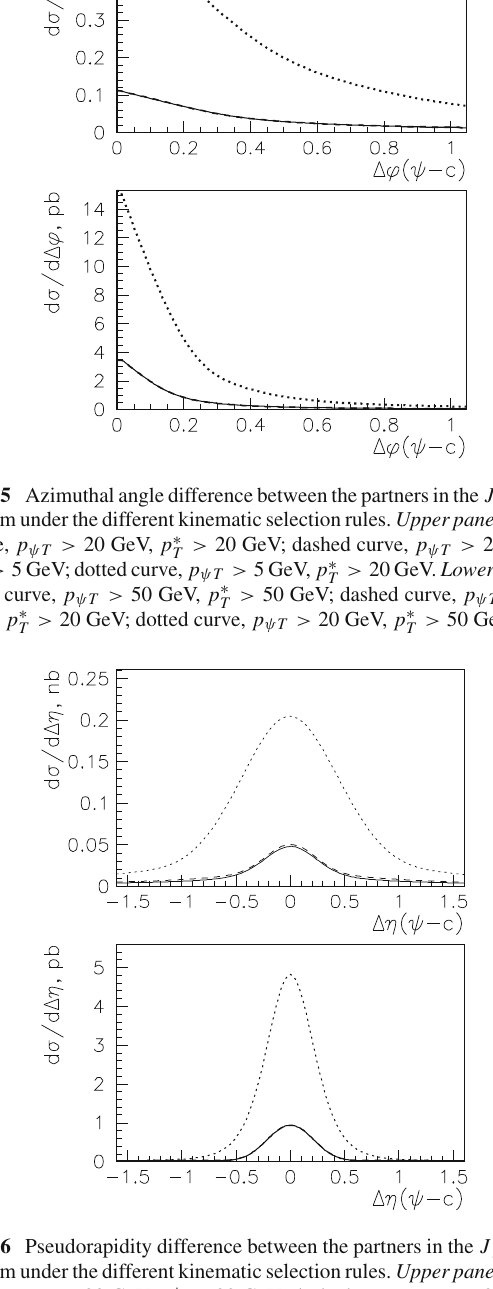
the shape of these distributions depends on the selected p ∗ indicates that we are not yet in the fragmentation